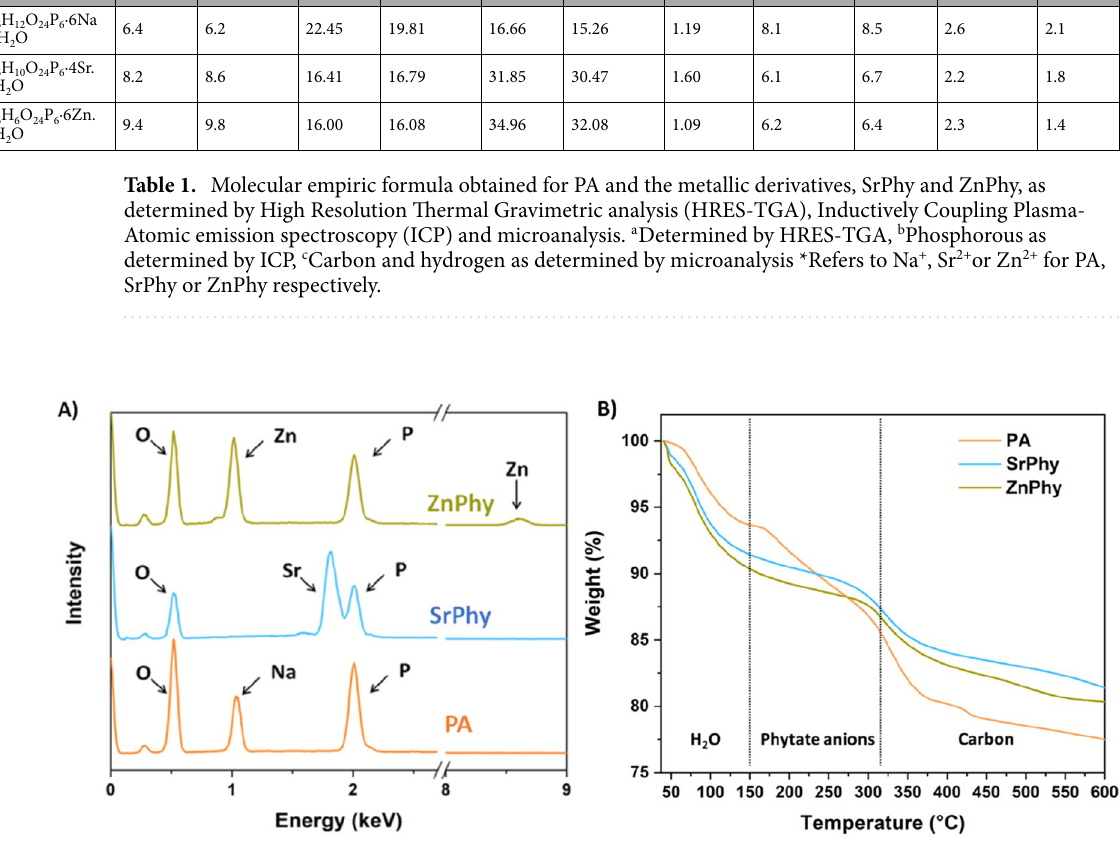
Figure 2. ( A ) EDS spectra registered for PA, SrPhy, and ZnPhy with assigned characteristic peaks and ( B ) HRES-TGA diagrams of PA, SrPhy and ZnPhy obtained under inert atmosphere. The dashed lines in the thermograms are shown to indicate the different regions of decomposition comprising water loss, phytate rings and organic